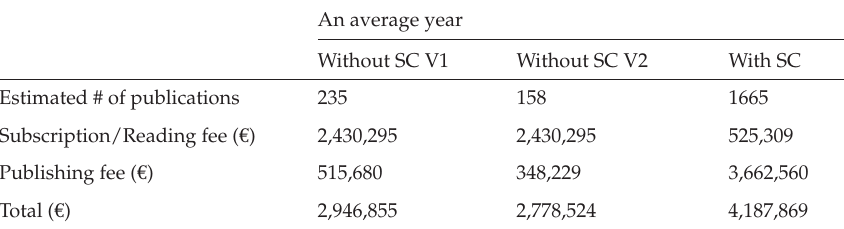
Table 3. Average costs per year 2016–2018, with and without Springer Compact (SC). Without SC V1 and V2 are hypothetical costs, had Springer Compact not been signed. V1 is based on the number of hybrid OA articles published in 2013–2016, assuming hybrid OA publishing with Springer Nature will increase. V2 makes a more conservative